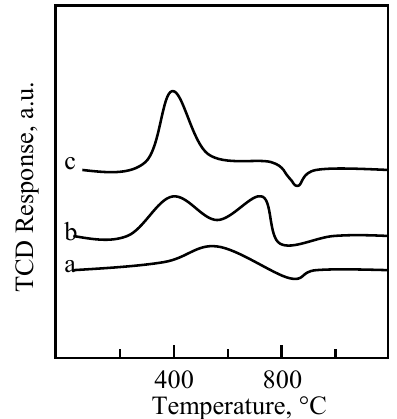
Figu TPR profiles of ( a ) activated carbon support, ( b ) catalyst Mo(18)/ AC(C), and ( c ) catalyst